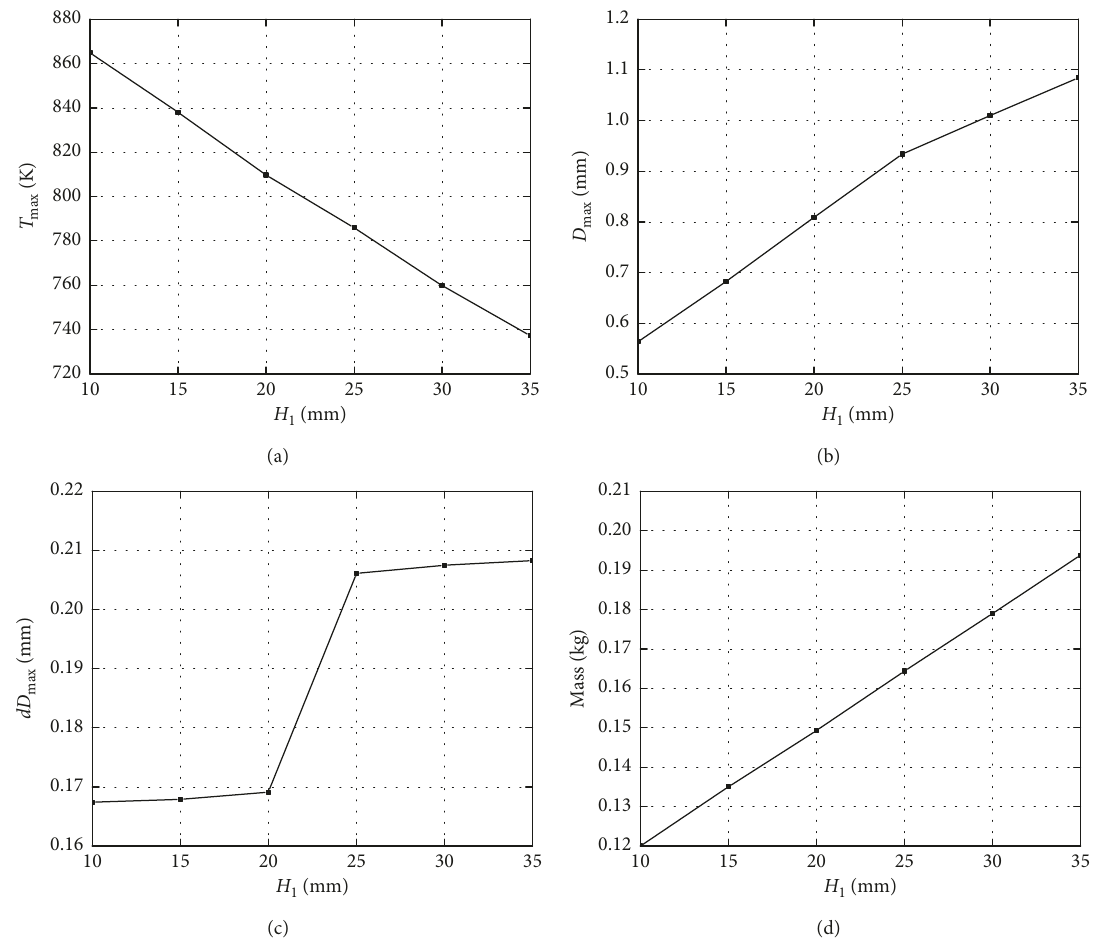
. (b) Deformation D max